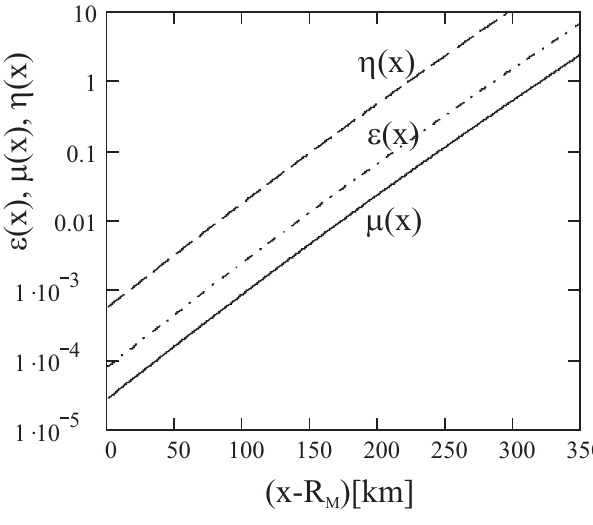
Fig. 9. Altitude dependence of the dimensionless parameters: dash, dash-and-dot, and solid lines are corresponding to η , (cid:15) , and µ , re-